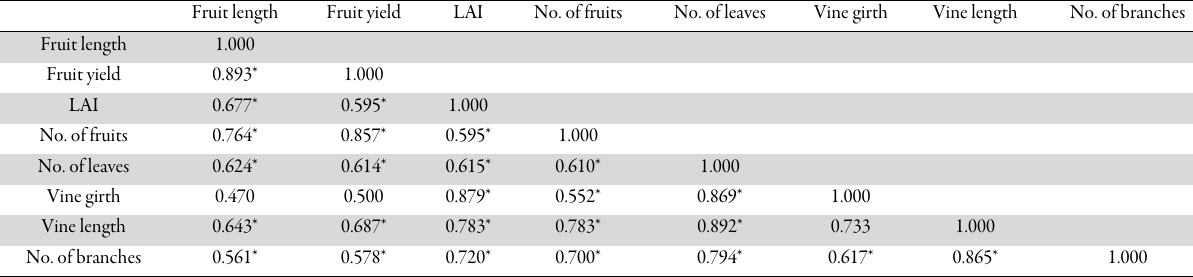
Table 3. Correlation matrix of dependable variables of cucumber Fruit length